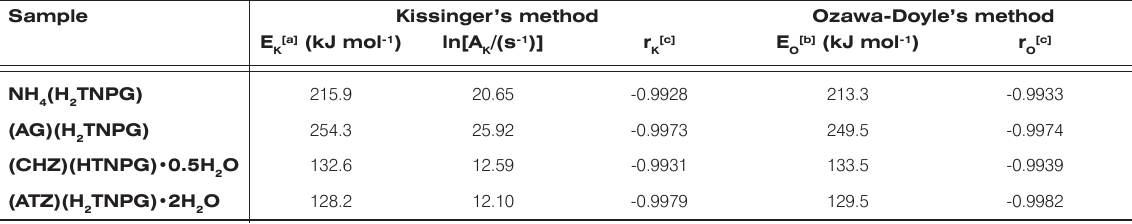
(H TNPG), (AG)(H 4 2